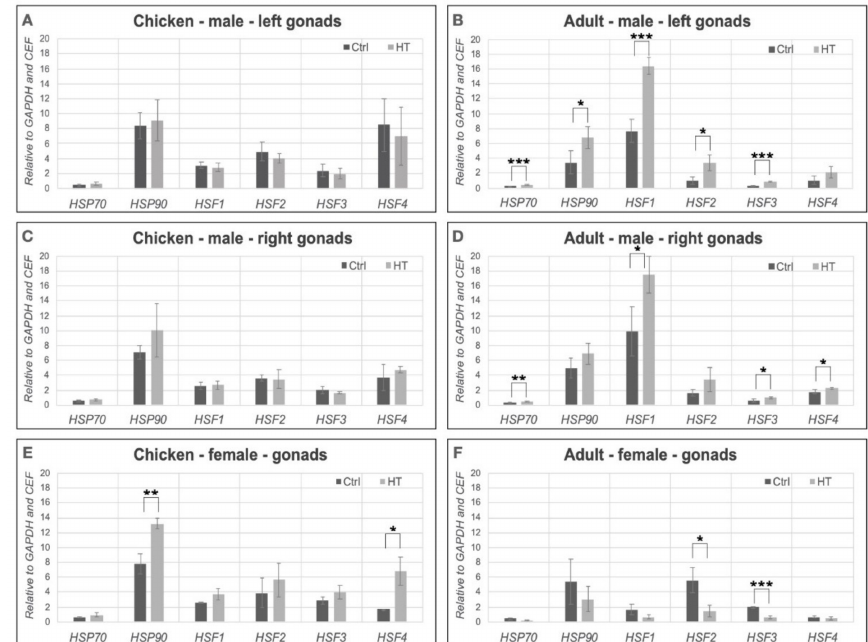
Figure 4. The bar charts show the relative expression values in female and male chick and adult samples in control and heat-treated gonads relative to chicken embryonic fibroblast sample. The relative expression values of heat-shock protein ( HSP70 and HSP90 ) and heat-shock factor ( HSF1, HSF2, HSF3, HSF4) genes were determined in female and male gonads. GAPDH was chosen as reference gene. ( A ): Chicken mal left gonads. ( B ): Adult male left gonads. ( C ): Chicken male right gonads. ( D ): Adult male right gonads. ( E ): Chicken female gonads. ( F ): Adult female gonads. * p < 0.05, ** p < 0.01, *** p <